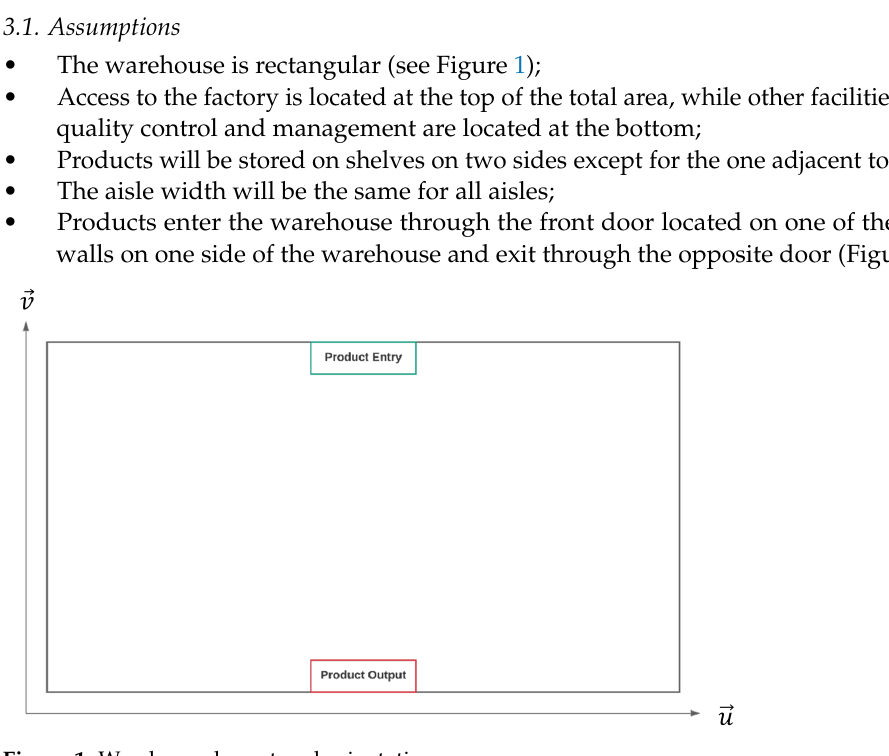
Figure 1. Warehouse layout and